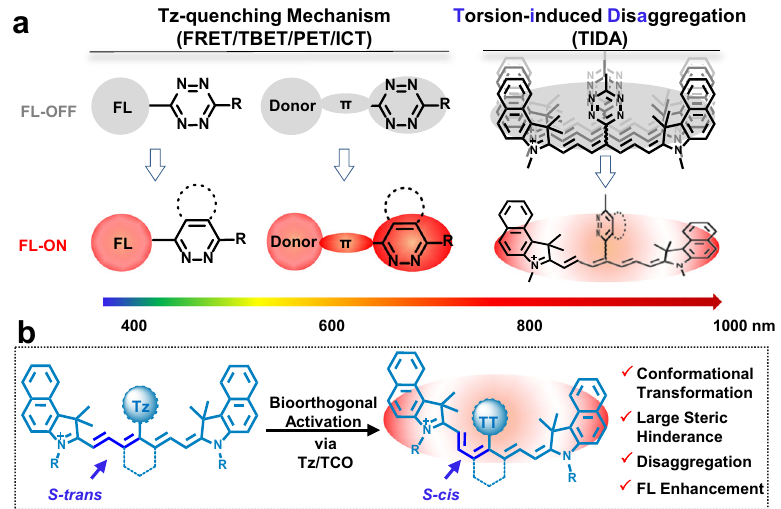
Fig. 1 Strategies for Tz-based bioorthogonally activatable probes. Tz-quenching mechanism ( a ) and the torsion-induced disaggregation (TIDA) for activatable NIR Tz-cyanine in our work ( b